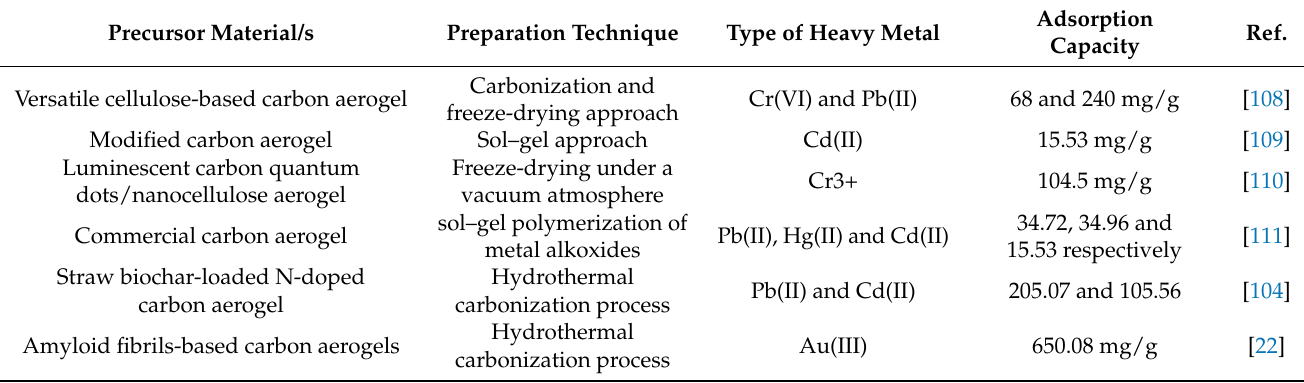
Table 3. Characteristics and adsorptive capacities of carbon and activated carbon nano-structured aerogels for heavy metal